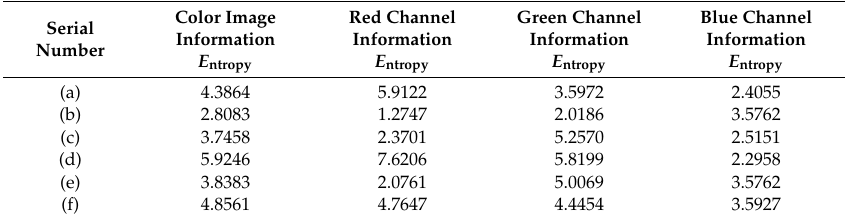
Table 5. The comparison of image information entropy.